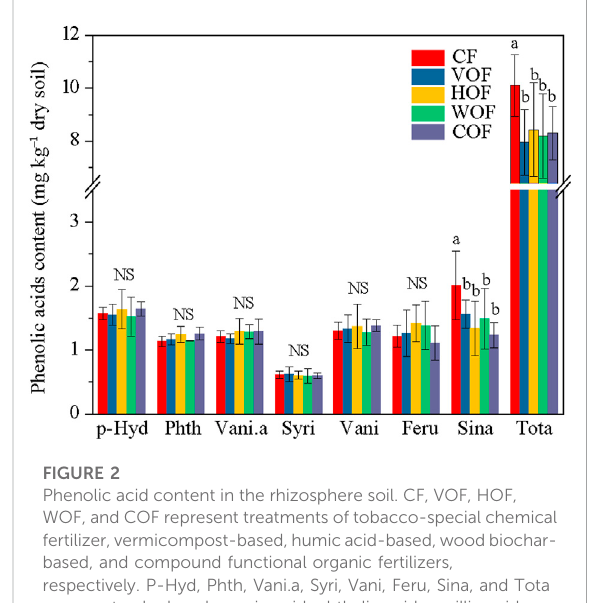
FIGURE 2 Phenolic acid content in the rhizosphere soil. CF, VOF, HOF, WOF, and COF represent treatments of tobacco-special chemical fertilizer,vermicompost-based,humicacid-based,woodbiochar- based, and compound functional organic fertilizers, respectively. P-Hyd, Phth, Vani.a, Syri, Vani, Feru, Sina, and Tota represent p -hydroxybenzoic acid, phthalic acid, vanillic acid, syringic acid, vanillin, ferulic acid, sinapic acid, and total phenolic acids, respectively. Different letters show a signi fi cant difference among the fi ve treatments based on the Duncan ’ s method ( p < 0.05), and NS indicates no signi fi cant difference ( p ≥ 0.05).